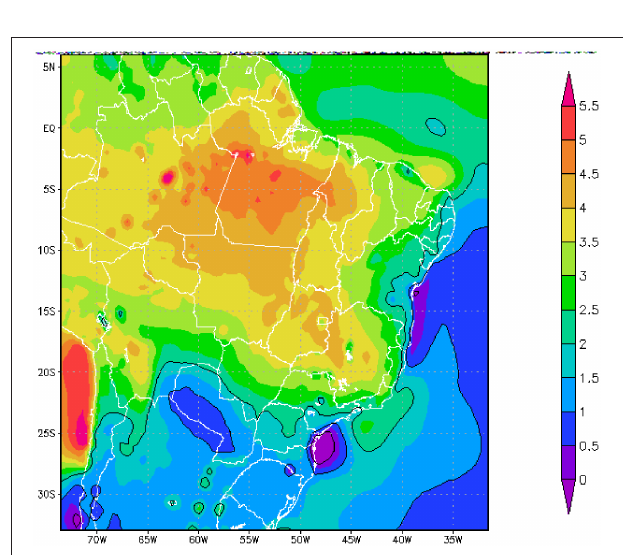
FIGURE 3 | Projected Surface Air Temperature changes ( ◦ C) for 2011–2040 relative to the climatological run (1960–1990).